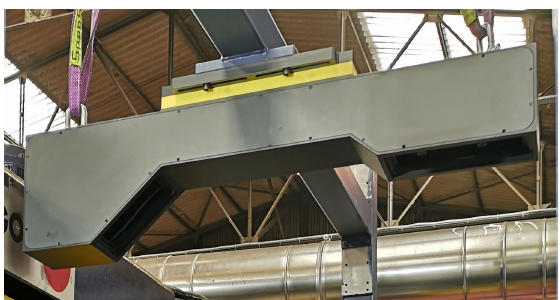
Figure 5. Close view of the devised sensor comprised of two linear lasers and a camera, installed over an industrial steel roll leveler processing